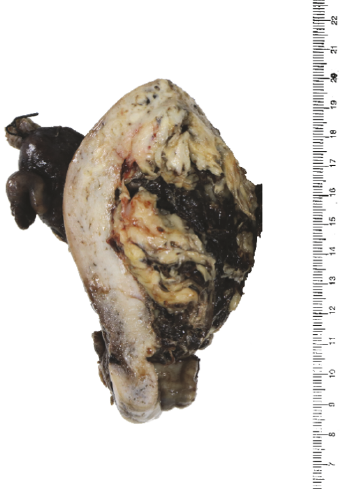
Figure 3: Cut surface of the resected